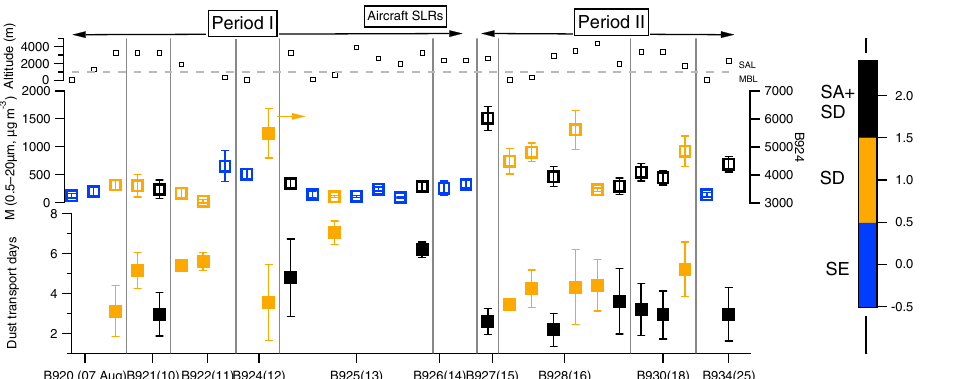
Figure 9. A summary of altitude, potential dust age and aerosol mass (0.5–20µm) for all aircraft SLRs. Note the aerosol mass for flight B924 is shown on the right axis. The numbers in brackets show the dates of flights in August. The grey dashed line indicates the layer height separating the SAL and